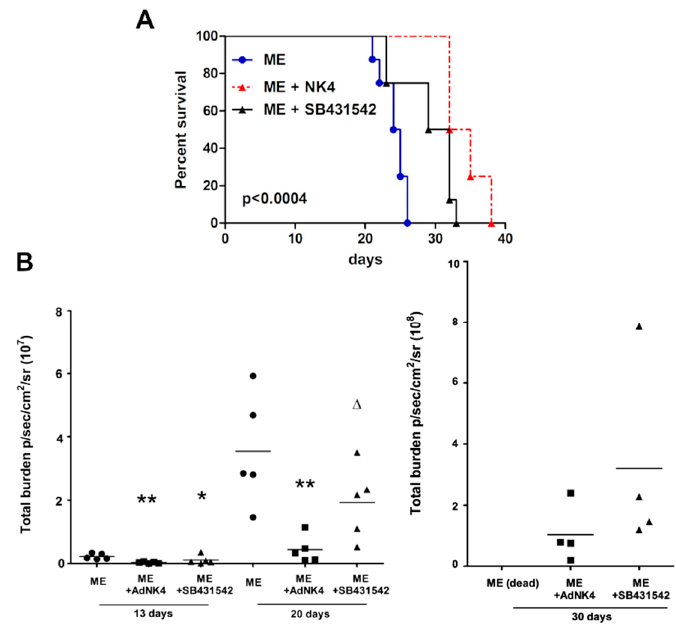
Figure 1. Effects of AdNK4 and SB431542 on animal survival and on bone metastasis outgrowth. ( A ) Survival curve on Kaplan–Meier plots of the data from mice exhibiting bone metastases (indicated as ME) exposed or not to AdNK4 or SB431542. The experiments started with 8 xenograft mice per group. ( B ) Changes of bioluminescence signals (total burden), corresponding to bone metastases of ME mice, treated or not with the inhibitors. The dot blots show the values of total burden for five mice at 13 and at 20 days, and for four mice at 30 days from 1833 / TGL cell injection. At 30 days ME mice were dead. * P < 0.05, ** P < 0.005 versus ME value at the corresponding time; ∆ P < 0.05 versus bioluminescence value under AdNK4 at 20 days.